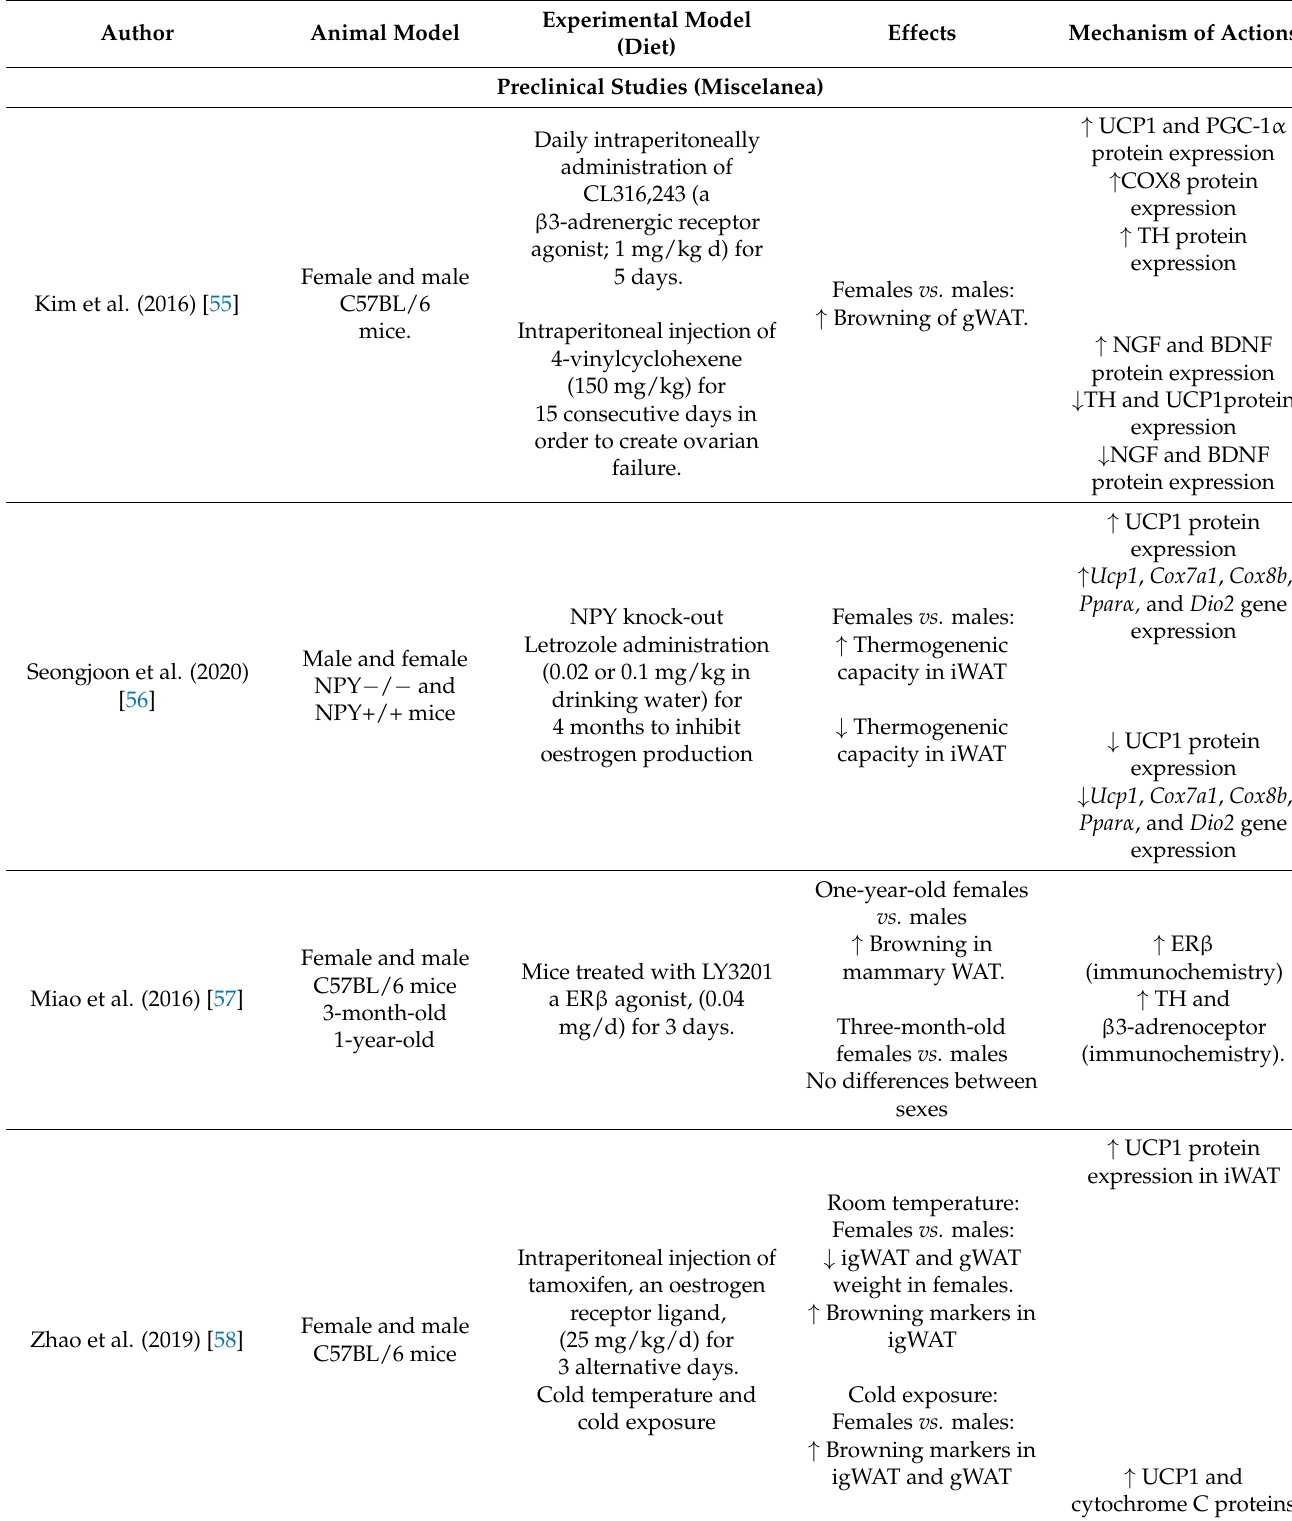
Table 4. Sexual dimorphism in WAT browning induced by different stimuli in preclinical